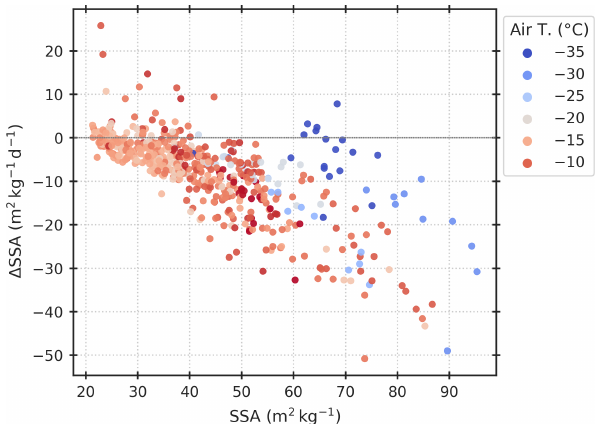
Figure A4. The change in SSA after 1 d (Day-1 to Day-0) plotted against the absolute value from Day-0 for all 21 SSA decay events (E1– E21 in Table A1) captured by the decrease threshold described in Sect. 2.5.1. The markers are coloured by mean air temperature between samplings (i.e. the mean air temperature from the time between sampling on Day-0 and Day-1).